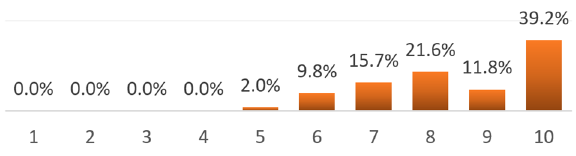
Figure 13. Does the model increase interest in structural statics? (1—absolutely no, 10—yes, very much).